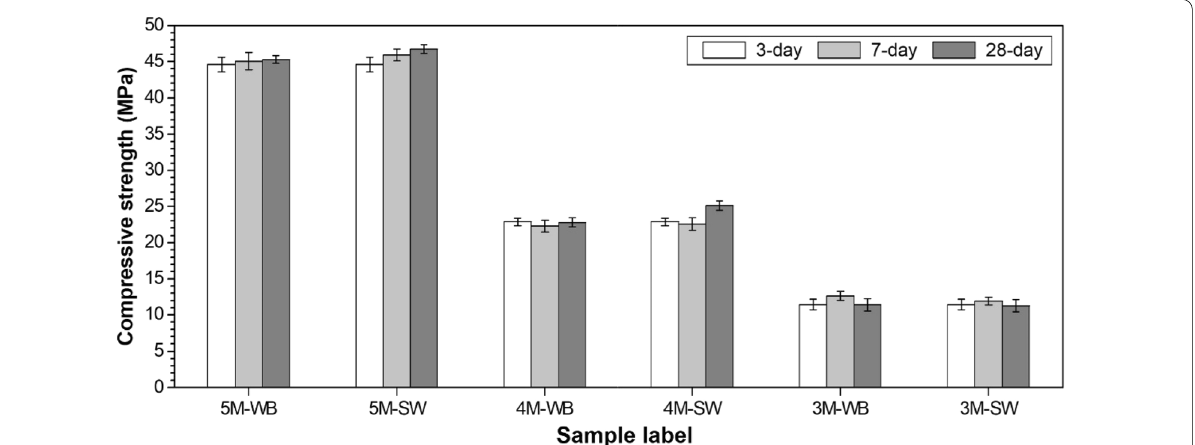
Fig. 2 Compressive strength of alkali-activated slag subjected to CO 2 , measured at 3 days, and its preservation at 7 or 28 days after subsequent water bath (WB) curing and immersion in seawater